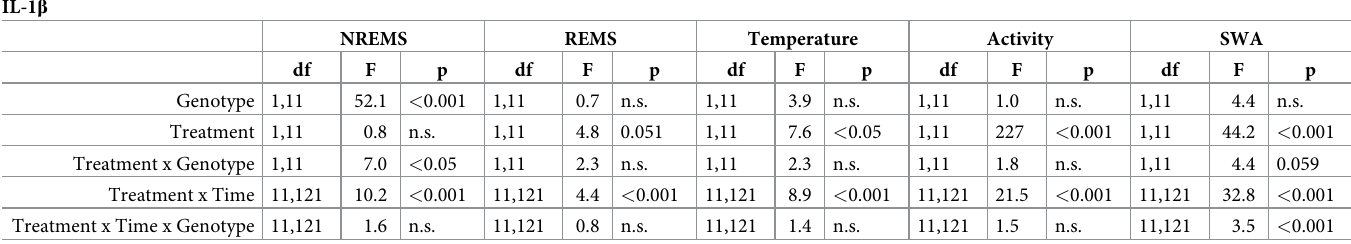
Table 5. Non-rapid-eye movement sleep (NREMS), rapid-eye movement sleep (REMS), body temperature, motor activity and electroencephalographic slow-wave activity (SWA) after IL-1 β administration: Statistical